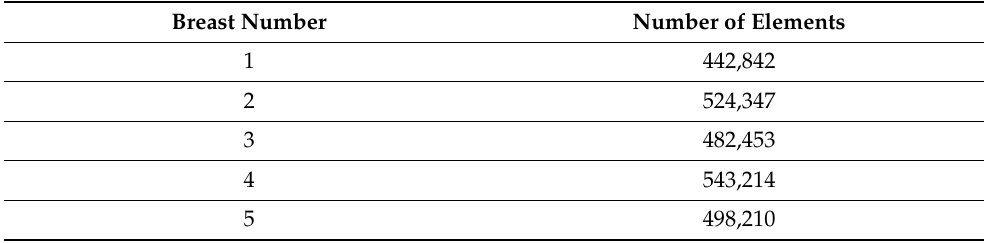
Table 5. Number of mesh elements for each breast.